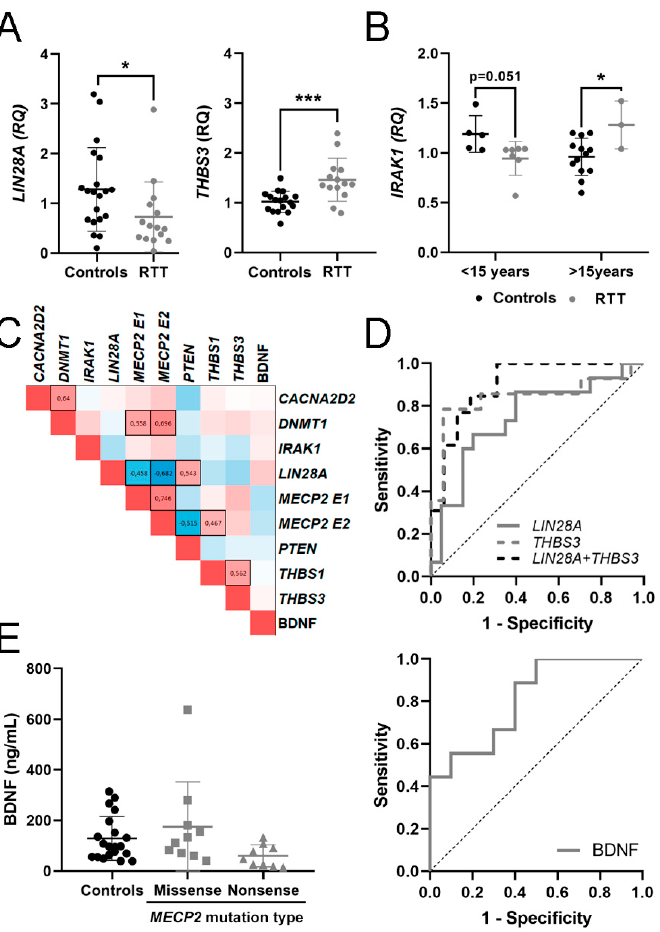
Figure 1. Potential mRNA biomarkers for Rett Syndrome (RTT) detection. ( A ) Graphs showing changes in mRNA expression of LIN28A and THBS3 between controls and RTT patients. ( B ) Changes in IRAK1 expression between controls and RTT patients in two age groups (<15 years, >15 years). ( C ) Heat map of Spearman correlation between gene expressions in whole blood; 1 is positive correlation, 0 no correlation and − 1 is negative correlation. Statistically significant correlations ( p < 0.05) are black boxed. ( D ) Receiver operating characteristic (ROC) curves for the candidate genes and their combinations assessing biomarker performance for RTT. ( E ) Graph showing changes in Brain-Derived Neurotrophic Factor (BDNF) protein dosage regarding methyl-CpG-binding protein 2 ( MECP2 ) mutation type and ROC curve assessing biomarker performance. * p < 0.05, *** p < 0.001 significant differences Mann–Whitney U